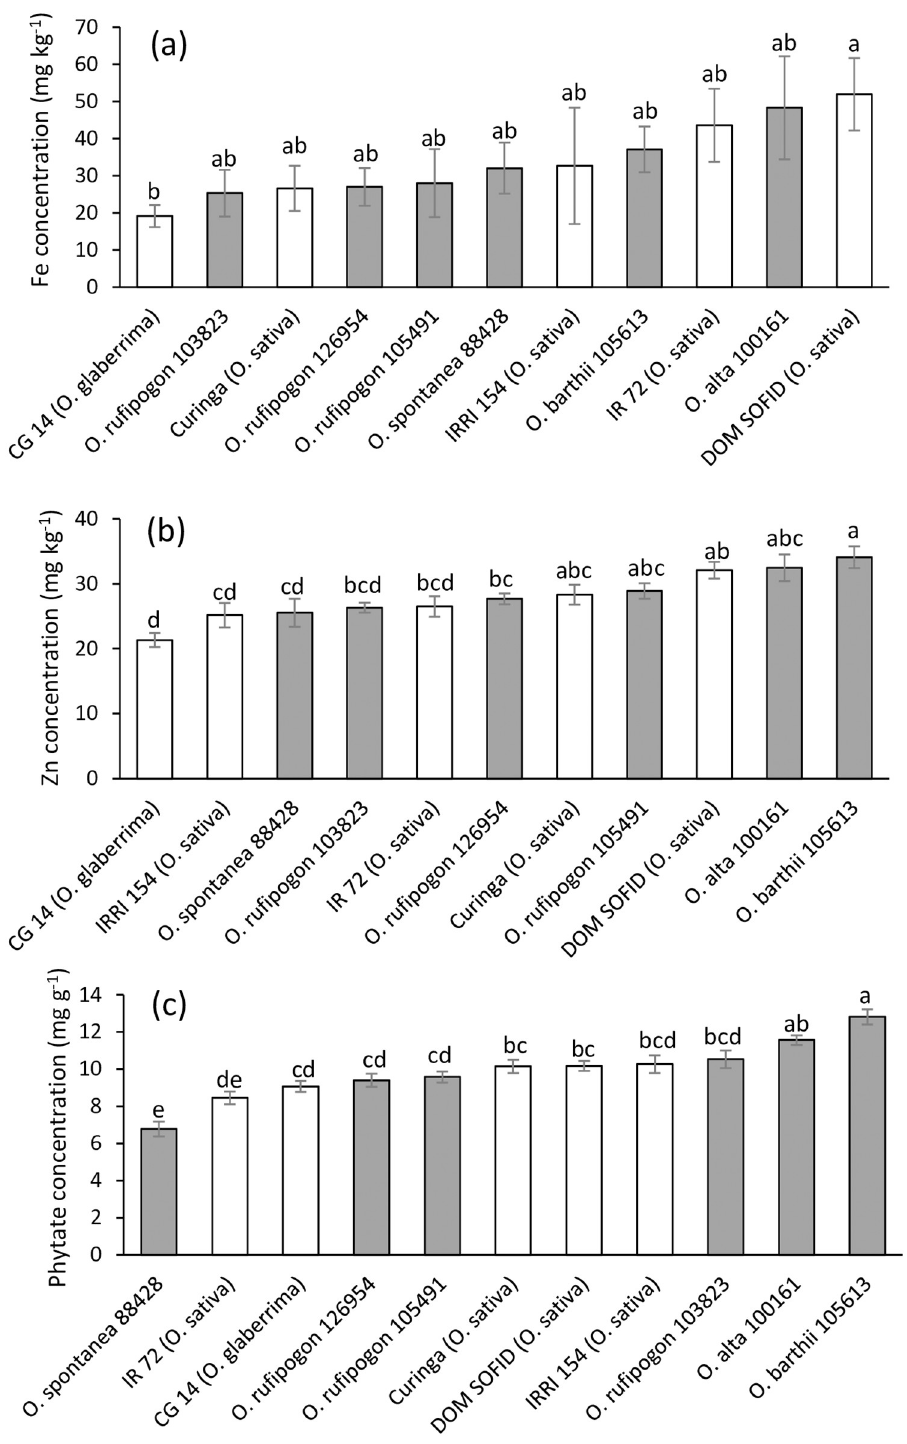
Fig 4. Brown rice mineral concentrations of selected domesticated rice varieties and rice wild relatives averaged across different treatments. (a) Fe concentration; (b) Zn concentration; (c) Phytate concentration. Mean values and standard errors (n = 5–12) are plotted. Bar not sharing the same letters differ significantly from each other by Tukey HSD test. White bars represent domesticated varieties while grey bars represent wild relatives.